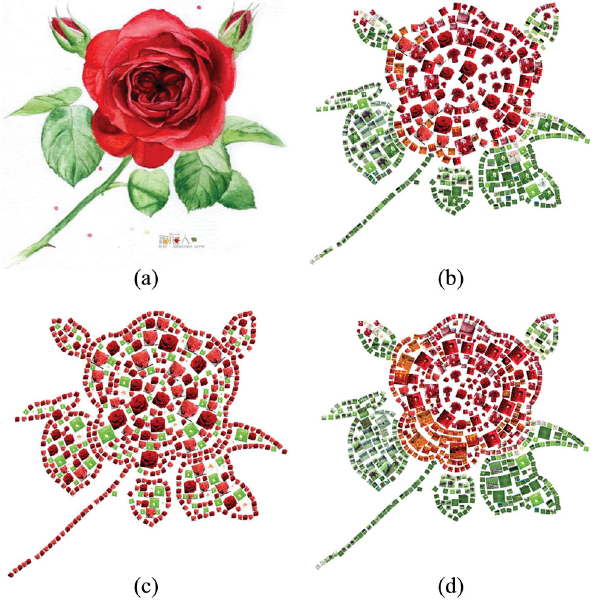
Fig. 7 Semantic-color similarity. (a) Source image. (b) Result generated considering both semantics and color. (c) Result only considering semantics. (d) Result only considering